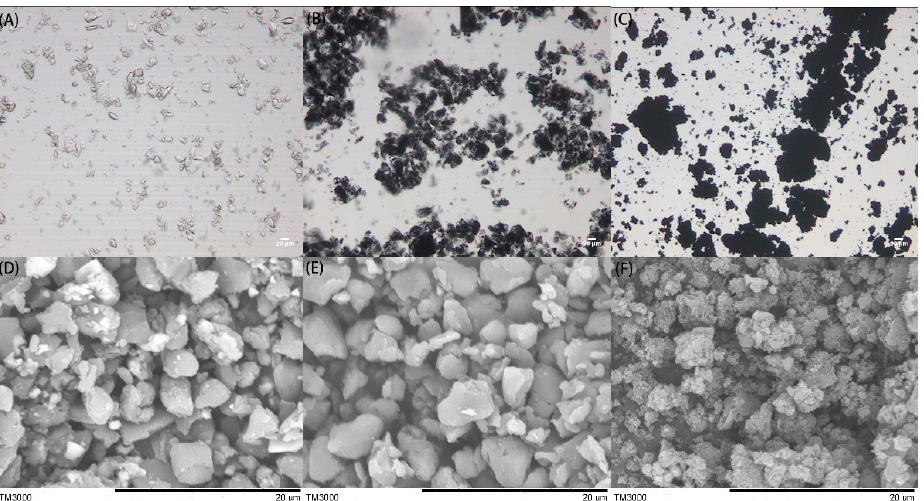
Figure 1. Optical microscopy photos ( A – C ) and scanning electron microscopy (SEM) images ( D – F ) of samples: ( A , D ) P[VBTMA][PF 6 ]; ( B , E ) P[VBTMA][PF 6 ]-c-PANI(40 wt %); ( C , F ) polyaniline (PANI).